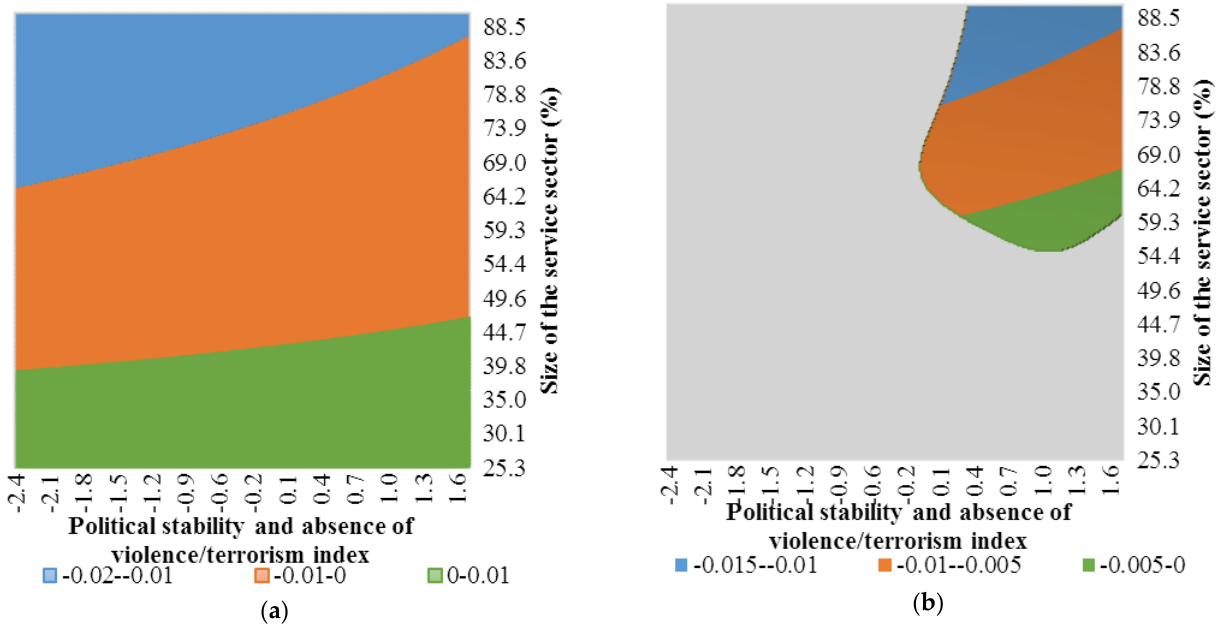
Figure A15. Conditional effect of financialisation on growth based on Est. 15 in Table A2. ( a ) Estimated conditional slope coefficient over the whole range of observed values for institutional quality and development level. ( b ) Estimated statistically significant conditional slope coefficient. Gray represents a combination of institutional quality and development level for which effect of financialisation on growth is statistically insignificant. Source: authors’ contributions.